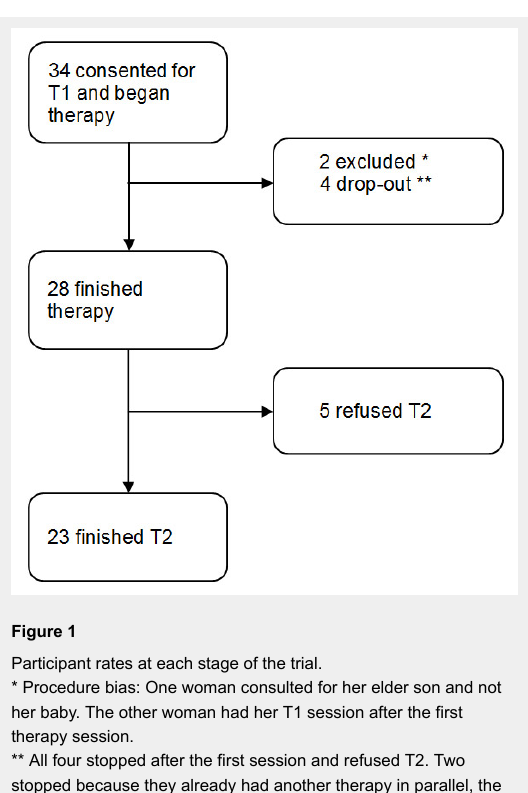
Participant rates at each stage of the trial. * Procedure bias: One woman consulted for her elder son and not her baby. The other woman had her T1 session after the first therapy session. ** All four stopped after the first session and refused T2. Two stopped because they already had another therapy in parallel, the two others did not give the